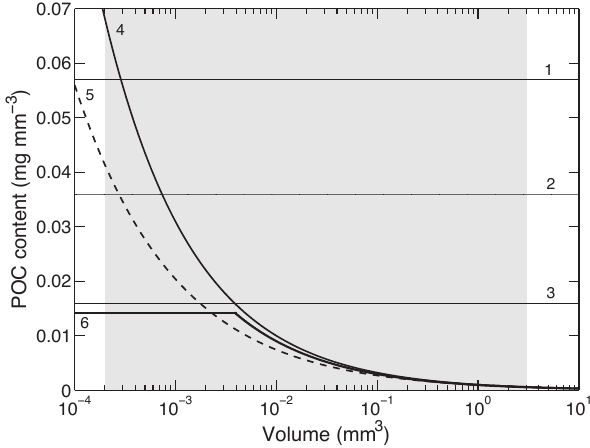
Figure 4. Empirical relationships of particulate organic carbon (POC) content as a function of volume for different categories of sinking particles. 1, 2 and 3: copepod fecal pellets, average of eu- phausiids and copepod fecal pellets and euphausiids fecal pellets respectively (González and Smetacek, 1994); 4: fecal marine snow (Alldredge, 1998); 5: diatom marine snow (Alldredge, 1998); 6: small and large aggregates (sensu lato) respectively (Ebersbach and Trull, 2008). The grey area represents the size range of particles pro- cessed in this study. Note the constant carbon mass per unit volume in fecal pellets based on solid geometry (linear relationship) and its decrease with increasing volume scaled on fractal geometry (power relationship) in the case of